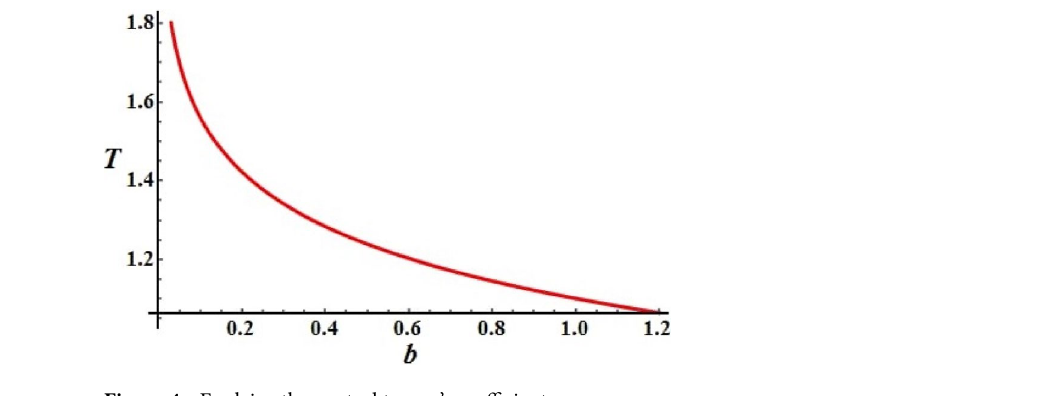
Figure 4. Explains the control torque’s